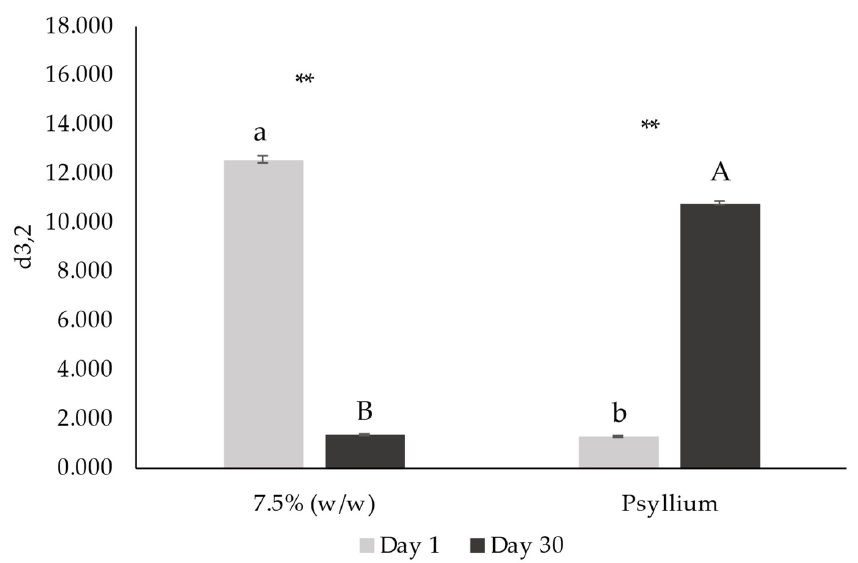
Figure 15. Sauter diameter (d 3,2 ) from droplet size distribution of emulsions with 7.5% ( w / w ) of miso paste, one of them with 0.1% ( w / w ) of psyllium husk, measured 1 (a) and 30 (b) days after emulsion preparation. Di ff erent le tt ers or two asterisks indicate signi fi cantly di ff erent results ( p < 0.05) according to t -test. Two asterisks indicate that samples presented signi fi cantly di ff erent results ( p > 0.05) according to t -test.